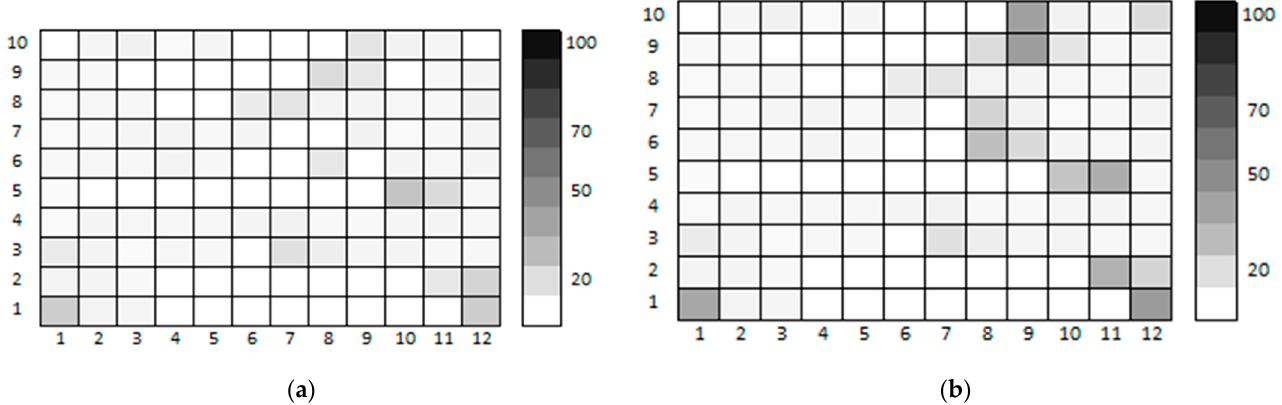
Figure 10. Visualization of deficit variation over the last ten years of the simulation period against real-time rule curves. ( a ) CPRC, ( b ) CHRC.